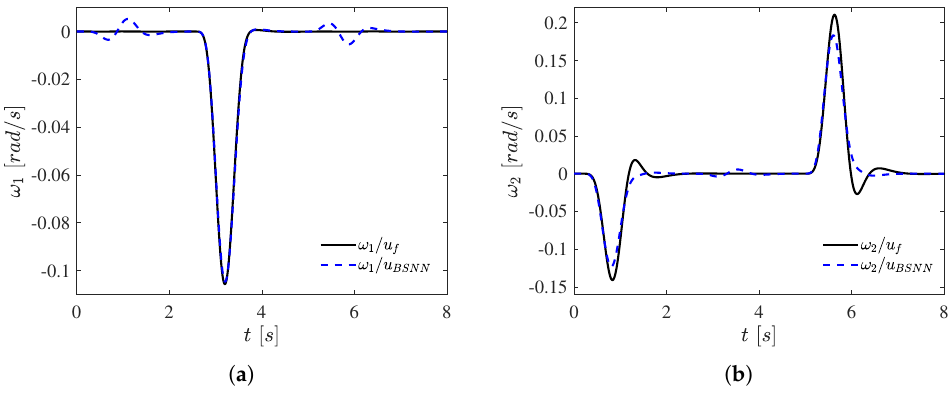
Figure 15. Speed deviation of ( a ) generator 1; ( b ) generator